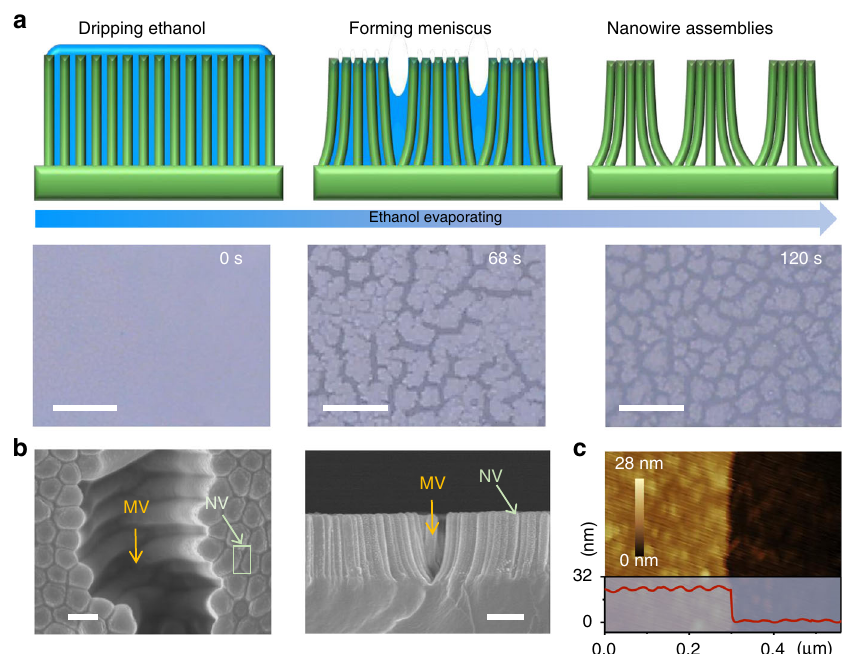
Fig. 1 Bioinspired hierarchical assembly of nanowires. a Schematic illustrations and corresponding optical micrographs of capillary force-induced assembly of nanowires (scale bar, 20 μ m). b SEM images of micro-voids between nanowire clusters and nano-voids among individual nanowires within a single nanowire cluster (scale bar in left and right fi gures are 500 nm and 2 μ m, respectively). MV (yellow arrow) and NV (green arrow) represent micro-voids and nano-voids, respectively. c Atomic force microscopy (AFM) topography image of the deposited 24-nm-thick Pt fi lm